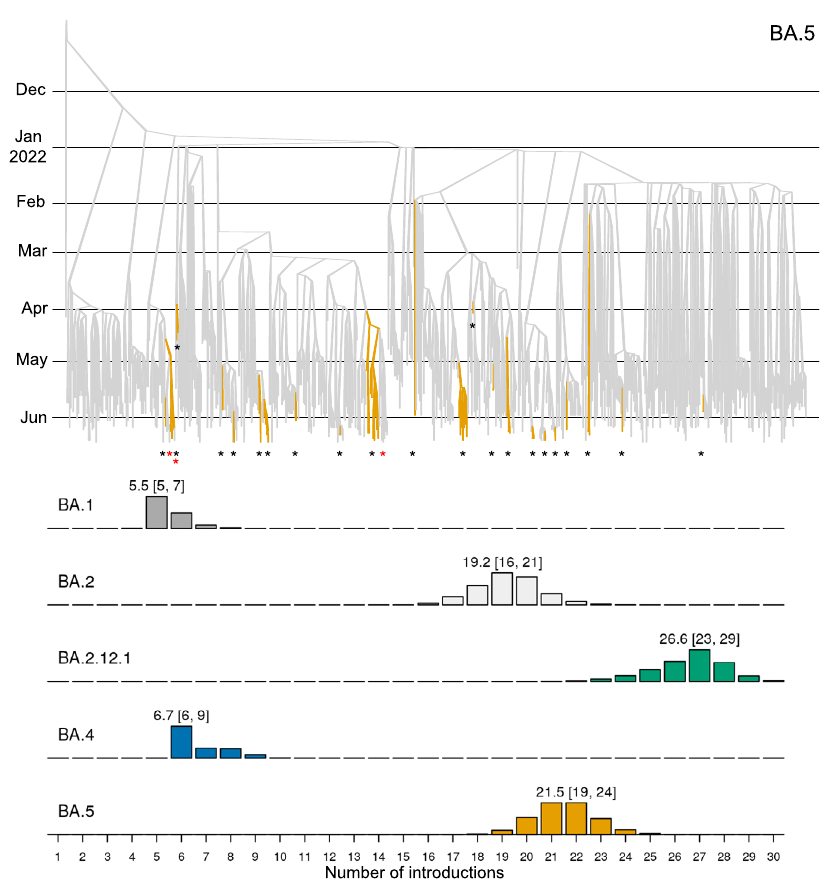
Fig. 3 | Discrete phylogeographical analysis of Omicron in New Zealand. Top: summary tree of the BA.5 analysis. Lineages are coloured by world (grey) or com- munity(orange).Introductionsfromtheworldintothecommunityareindicatedby black stars *, while export events from the community to the border (i.e. new arrivals who acquired their infection from the New Zealand community) are